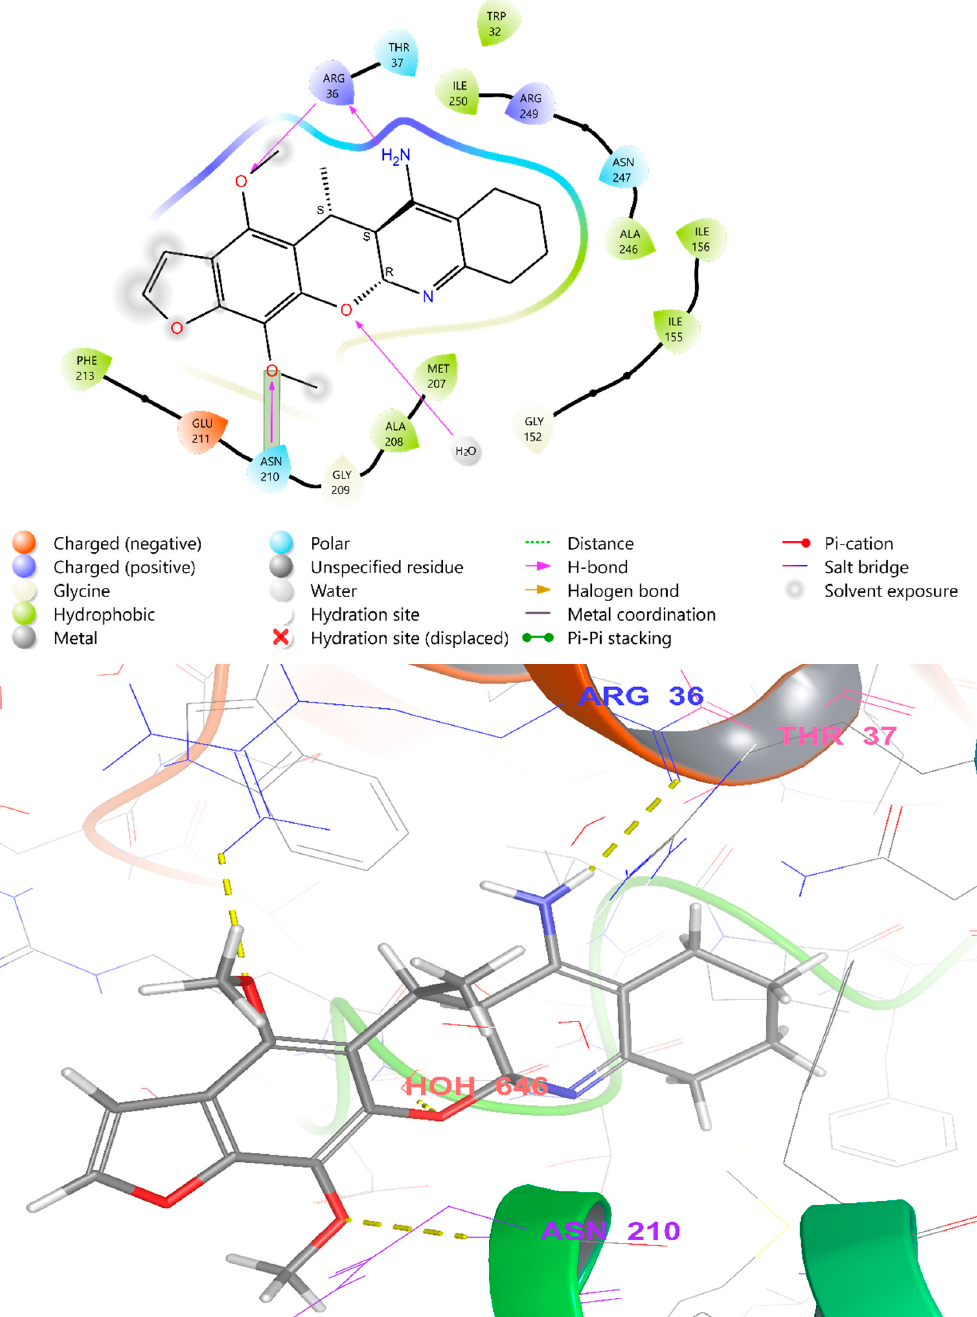
Figure 2. The three-dimensional docked poses of the best compound, ( 21b ), with active amino acid residues of 1HNJ protein are visualized by Maestro. The two-dimensional interactions of the lead molecule are from the Schrodinger suite.